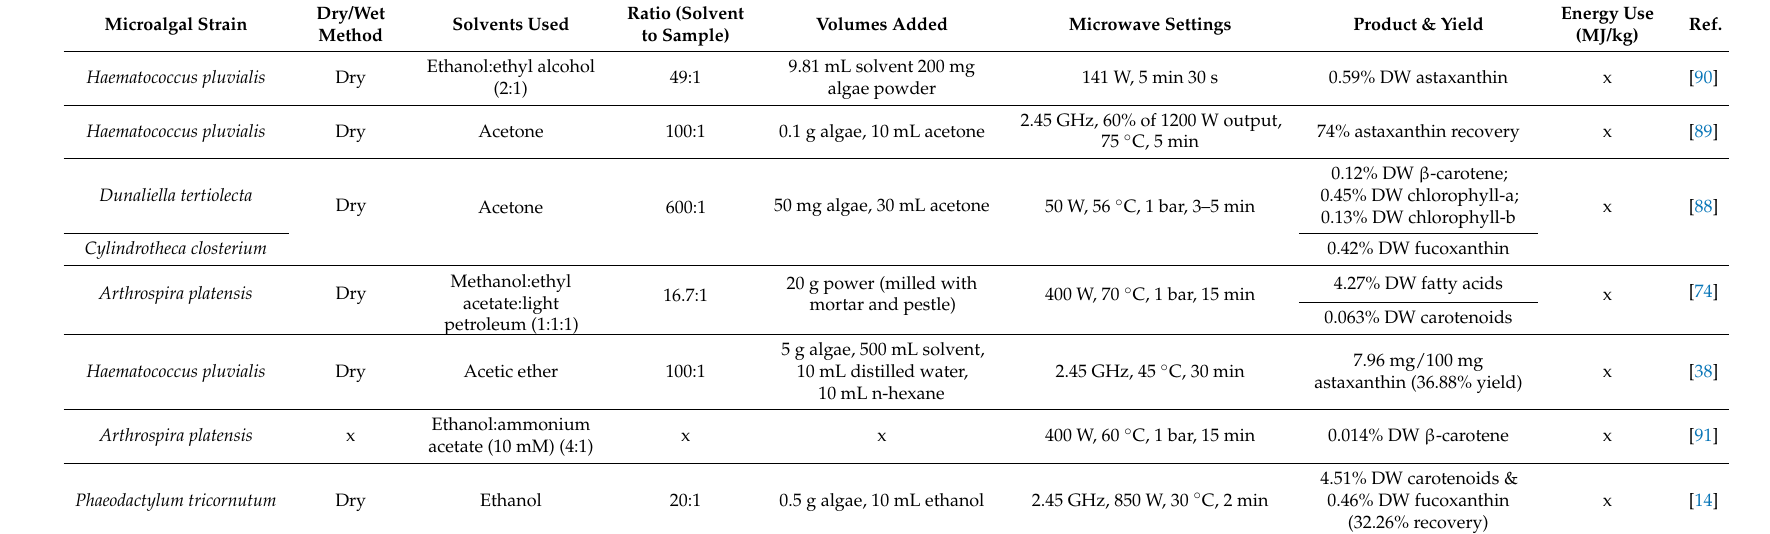
Table 4. Pigments extracted from microalgae by